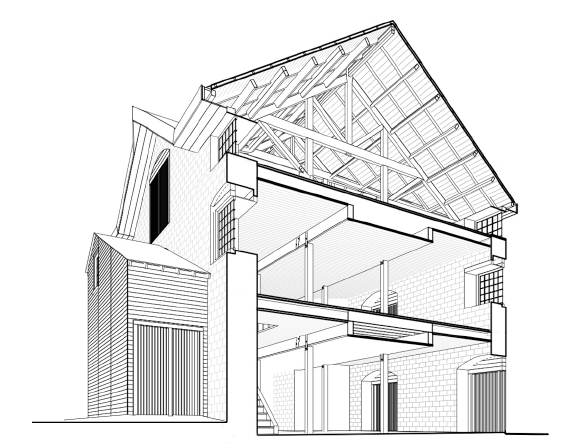
Figure 10. Commissariat Building, BIM perspectival